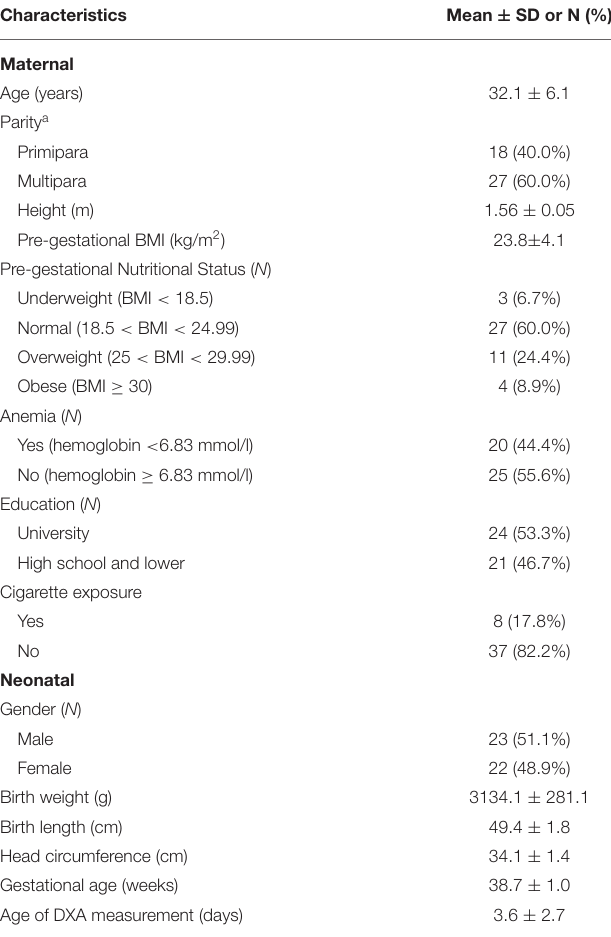
TABLE 2 | Mean ± SD BMC of whole body, whole body except head, trunk and legs.